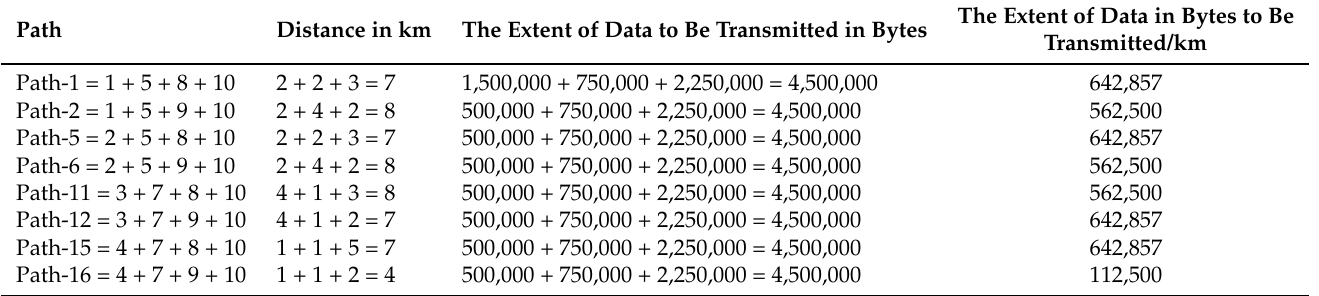
Table 3. Distance and traffic computations of pruned